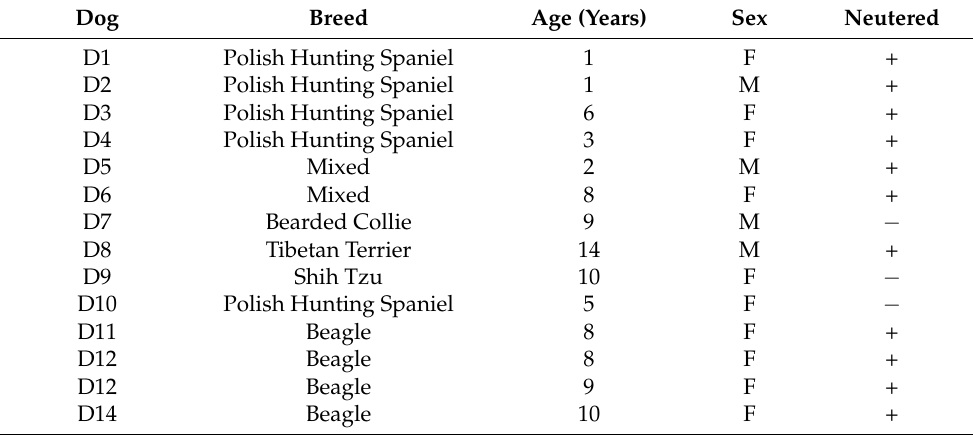
Table 1. Dogs used in